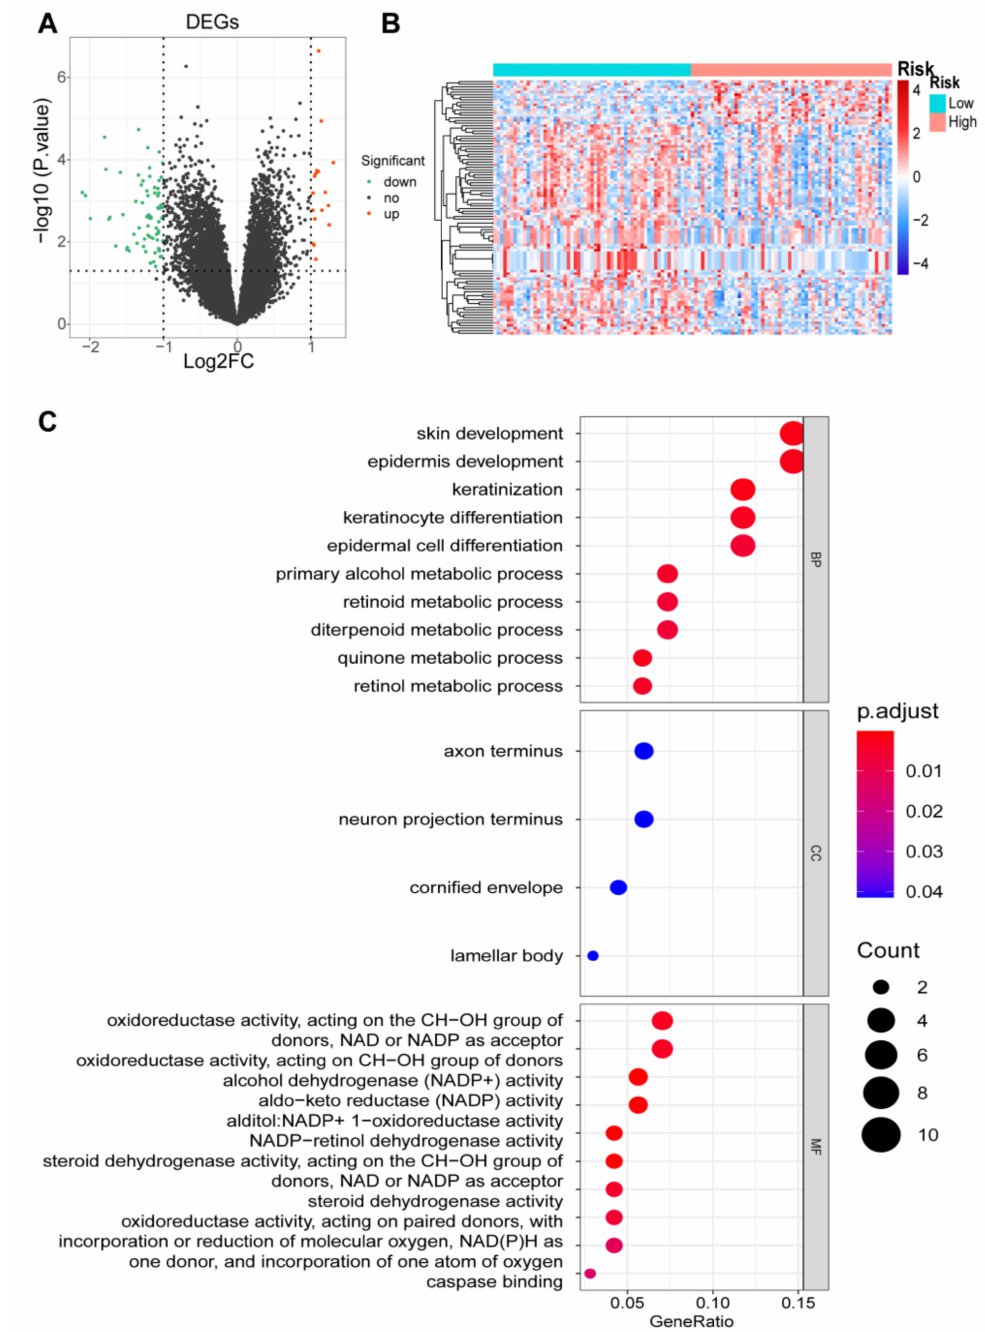
Figure 8. DEGs functional enrichment analysis; ( A ) The volcano plot of the upregulated and down- regulated DEGs; ( B ) Heatmap for the hierarchical cluster analysis of high- and low-risk sample; ( C ) Top 10 enriched GO terms for